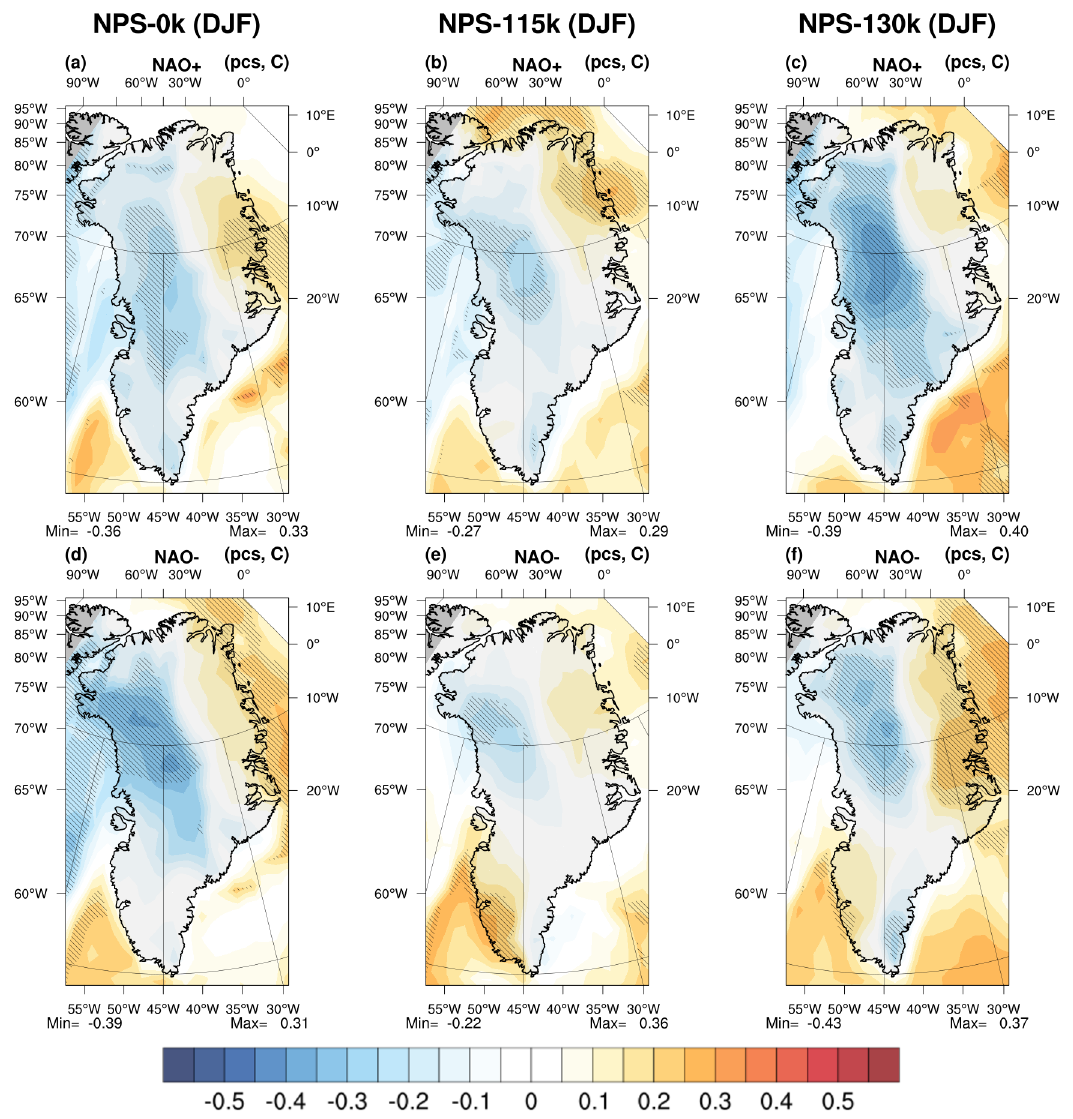
Figure 11. Spatial correlation between accumulation and the NAO index in winter for (a, d) the preindustrial period, (b, e) 115ka and (c, f) 130ka. Top (bottom) row: positive (negative) NAO situations (sampled for NAO indices with absolute value higher than 1 standard deviation). Dotted areas represent correlations significant at the 99%